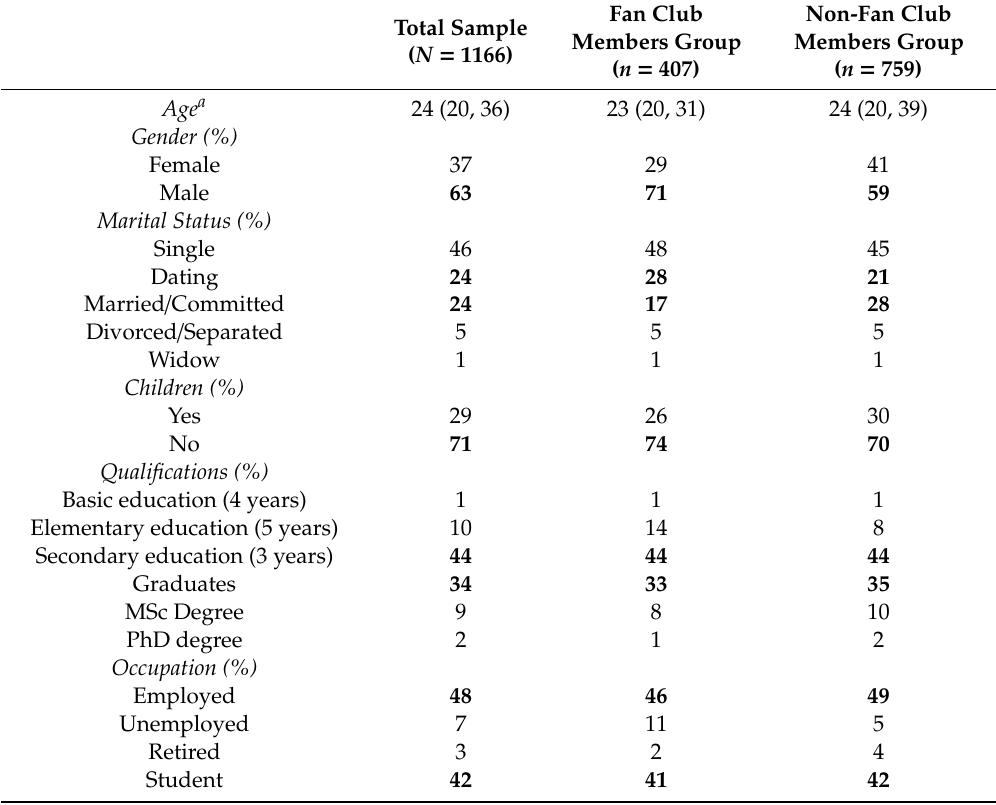
Table 2. Sociodemographic characterization of the overall sample and subsamples.